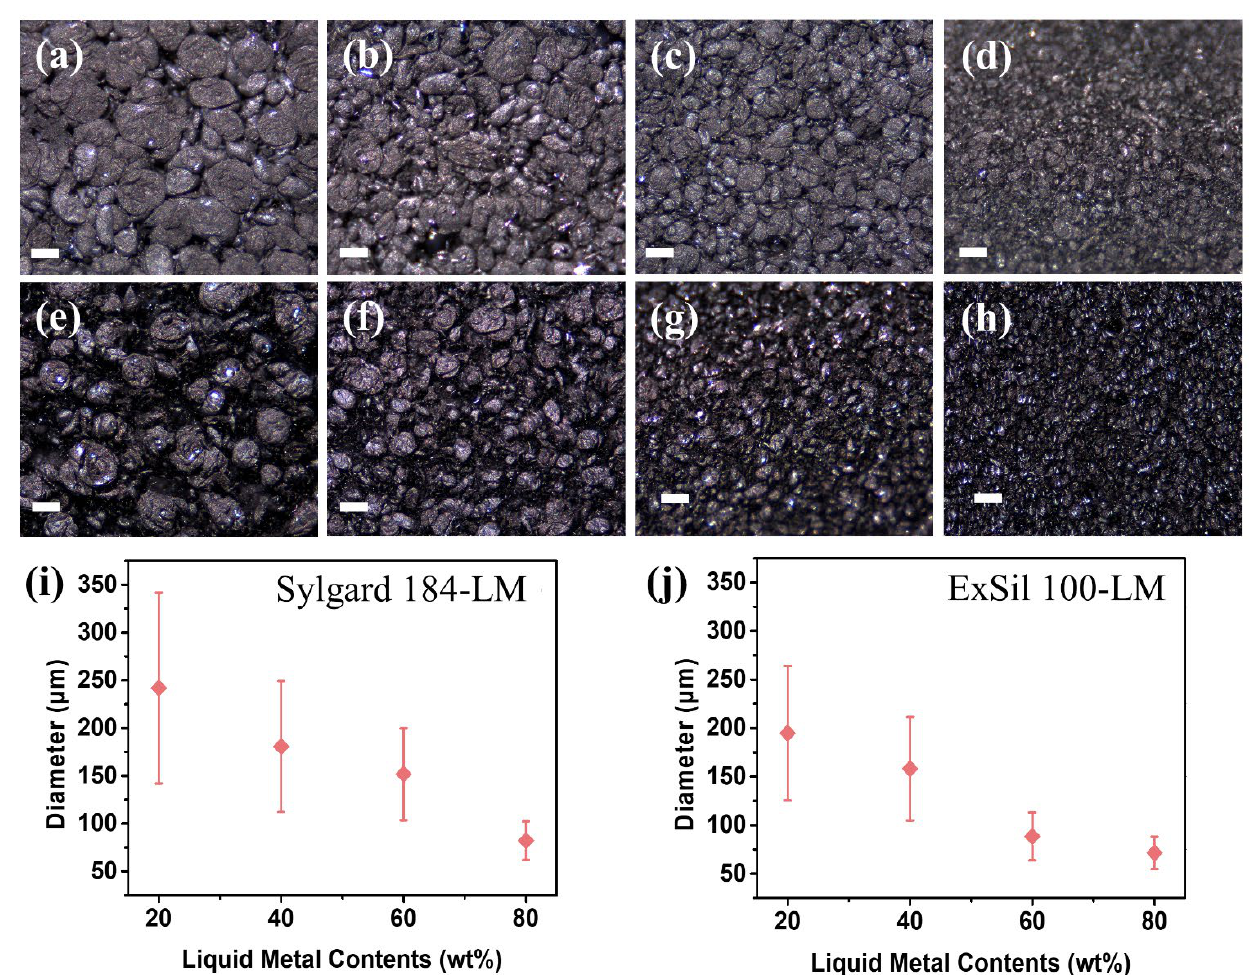
Figure 3. Optical microscopy images showing ( a – d ) the Sylgard 184 and ( e – h ) the ExSil 100 with the various contents of the liquid metal fillers. ( a ) 20 wt%, ( b ) 40 wt%, ( c ) 60 wt%, and ( d ) 80 wt% of the liquid metal fillers. The scale bar represents 200 μm. ( i , j ) The diameters of the liquid metal droplets dispersed in ( i ) Sylgard 184 and ( j ) ExSil 100 according to various contents of the liquid metal fillers.